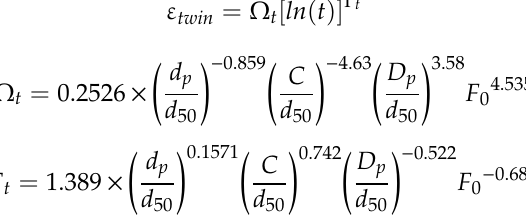
Time-Dependent Scour Depth of Variation (%) 7200 s (mm)